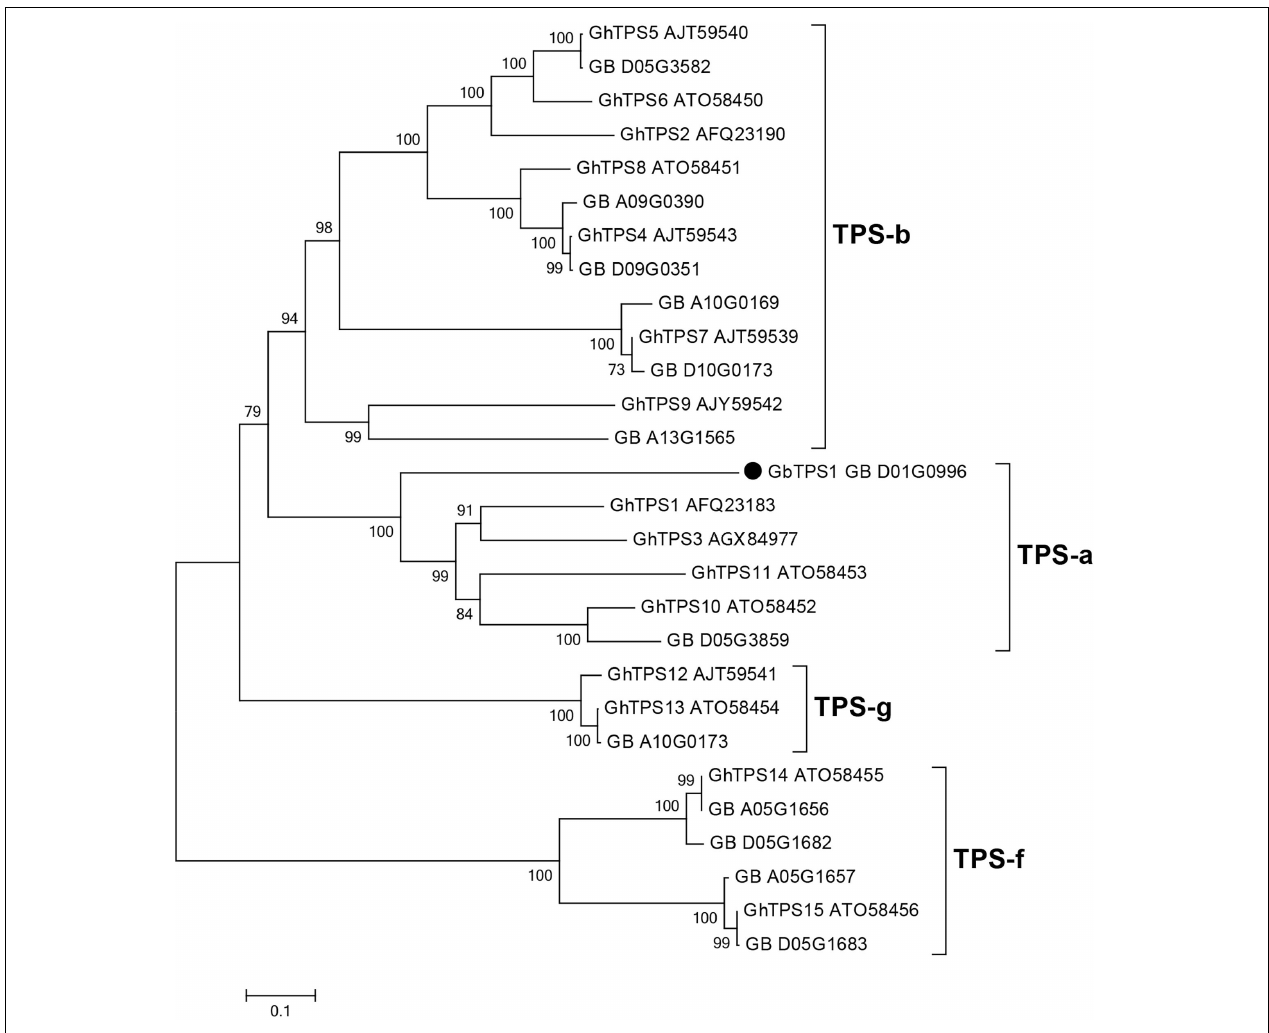
FIGURE 4 | Phylogenetic tree of amino acid sequences of 13 TPSs identified in the transcriptome from G. barbadense leaves and previously characterized TPSs (GhTPS1-GhTPS15) from Gossypium hirsutum . The tree was constructed with the neighbor-joining method and 1,000 replications for bootstrapping.